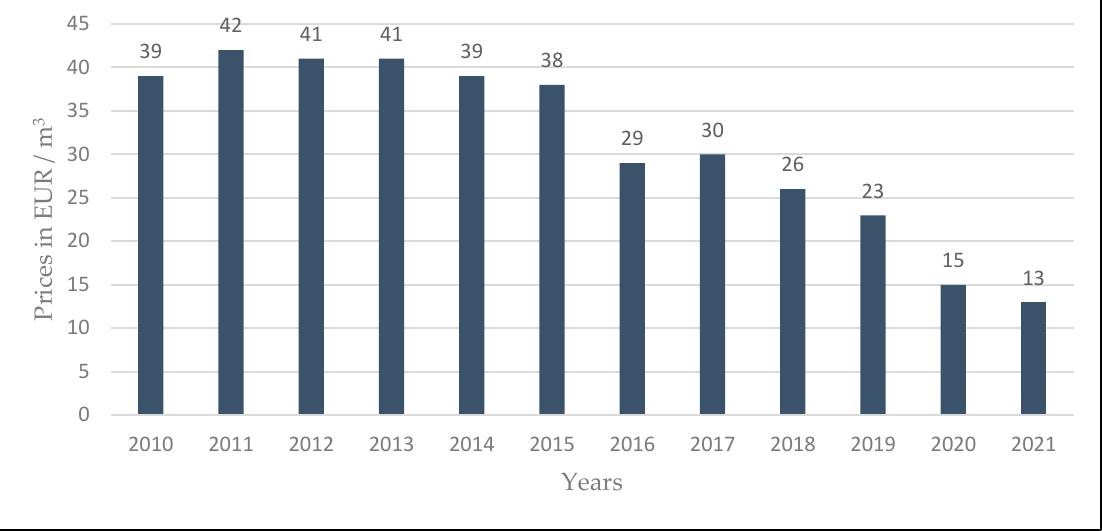
Figure 3. Price of pulp in the Czech Republic; Source: Č SU (Czech Statistical Agency) 2021, Forestry.